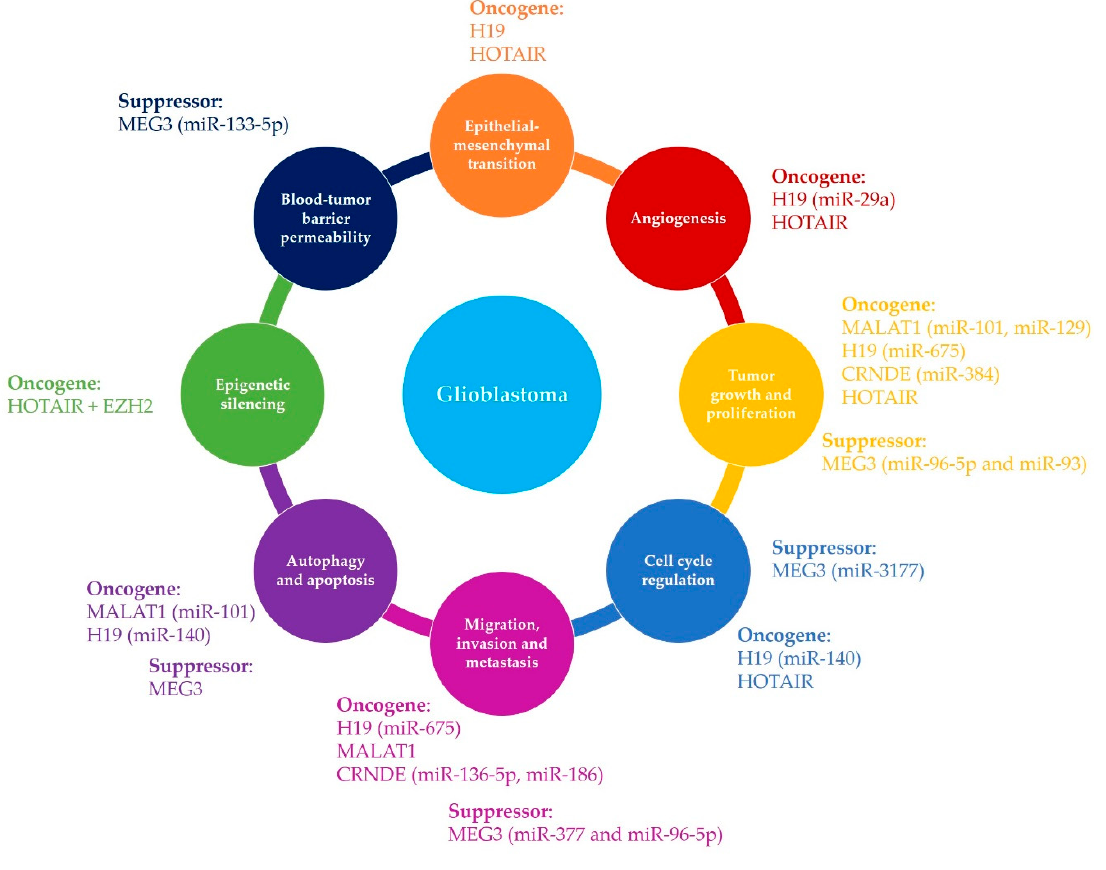
Figure 2. Schematic illustration of the diverse mechanisms by which different lncRNAs are involved in glioblastoma occurrence and progression. lncRNAs contribute to glioblastoma pathogenesis by involvement in different molecular mechanisms including cell proliferation, stemness, angiogenesis, and migration, as well as epigenetic regulation.